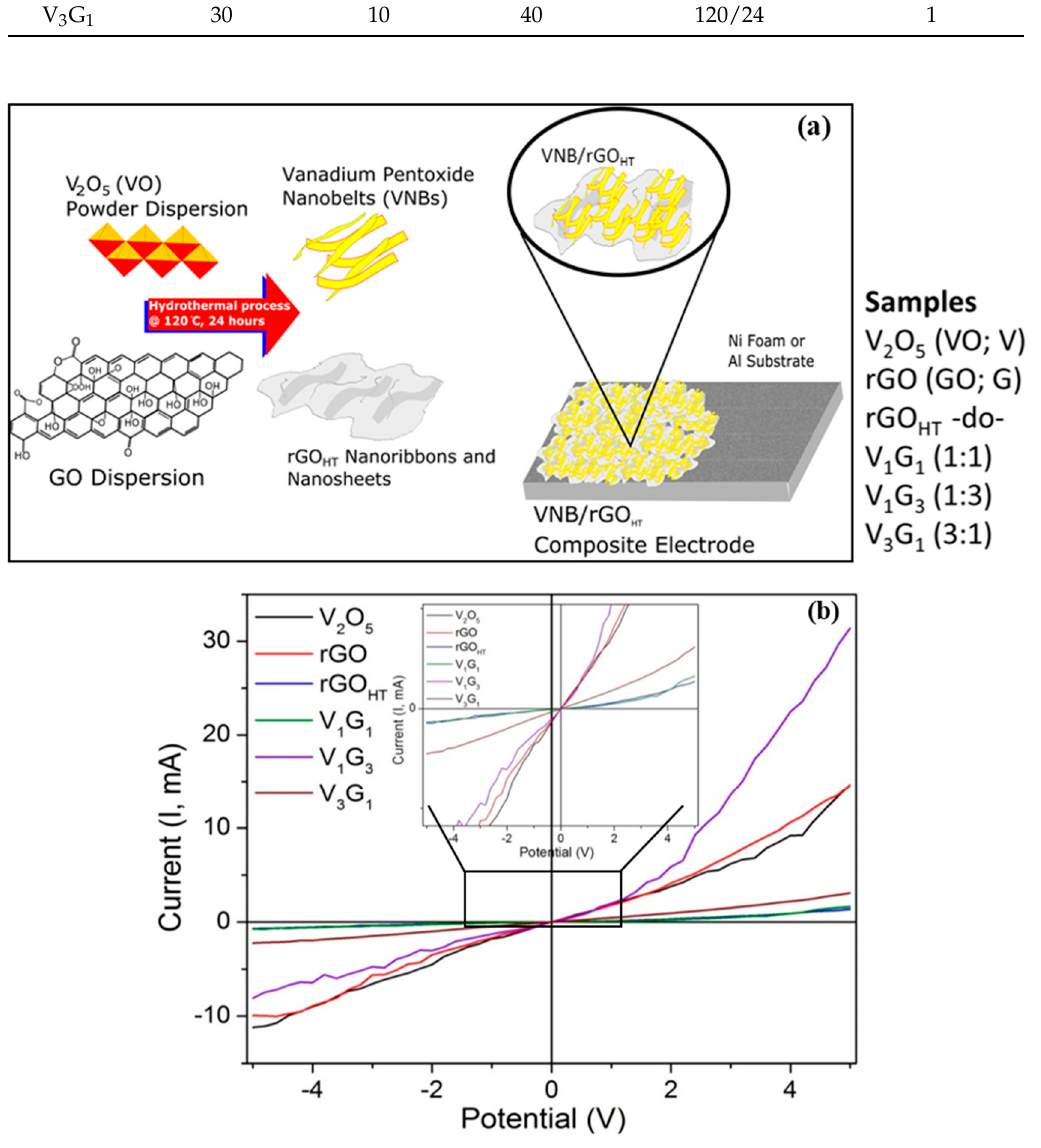
Figure 1. ( a ) Schematic of the composite electrodes comprised of vanadium pentoxide (VO) nanobelts (VNBs) and rGO nanosheets/nanoribbons in different composition ratios using hydrothermal synthesis technique; ( b ) room temperature I – V electrical properties showing quasi ‐ linear (or non ‐ ohmic)